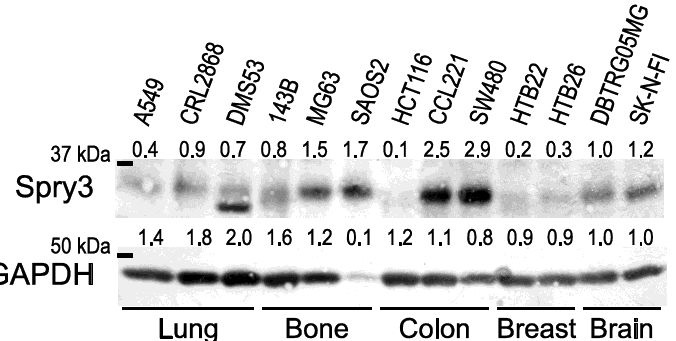
Figure 1. Expression of Spry3 protein in cancer-derived cell lines. An immunoblot of logarithmically growing cells of the indicated cell lines derived from lung, bone, colon, breast and brain cancers was performed and sequentially probed with antibodies recognizing Spry3 and GAPDH, respectively. Quantification of the immunoblot was performed using ImageQuant software (Molecular Dynamics, Sunnyvale, CA, USA). DBTRG05MG was arbitrarily set as